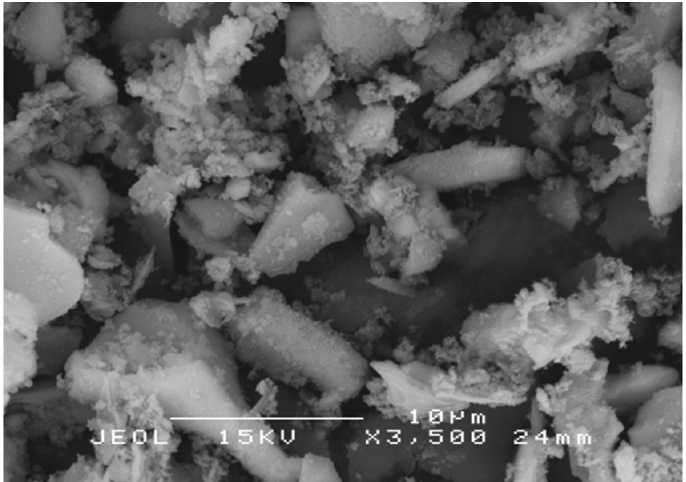
Figure 2. SEM for Rice Husk Ash (RHA) particles.